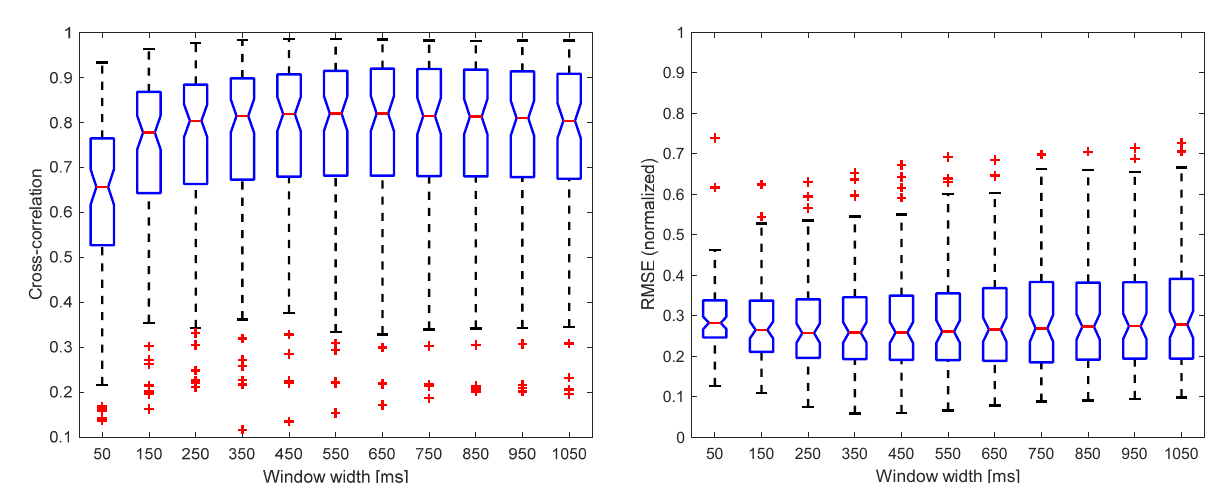
Figure A2. RMSE ( left ) and cross-correlation ( right ) of WL algorithm for different window sizes. Table A2. Statistical significance between window sizes for WL algorithm. Green indicates statisti- cally significant difference ( p < 0.05; Bonferroni-corrected) for the RMSE metric, and orange indicates significant difference ( p < 0.05; Bonferroni-corrected) for the cross-correlation metric. Grey indicates diagonal fields. ms